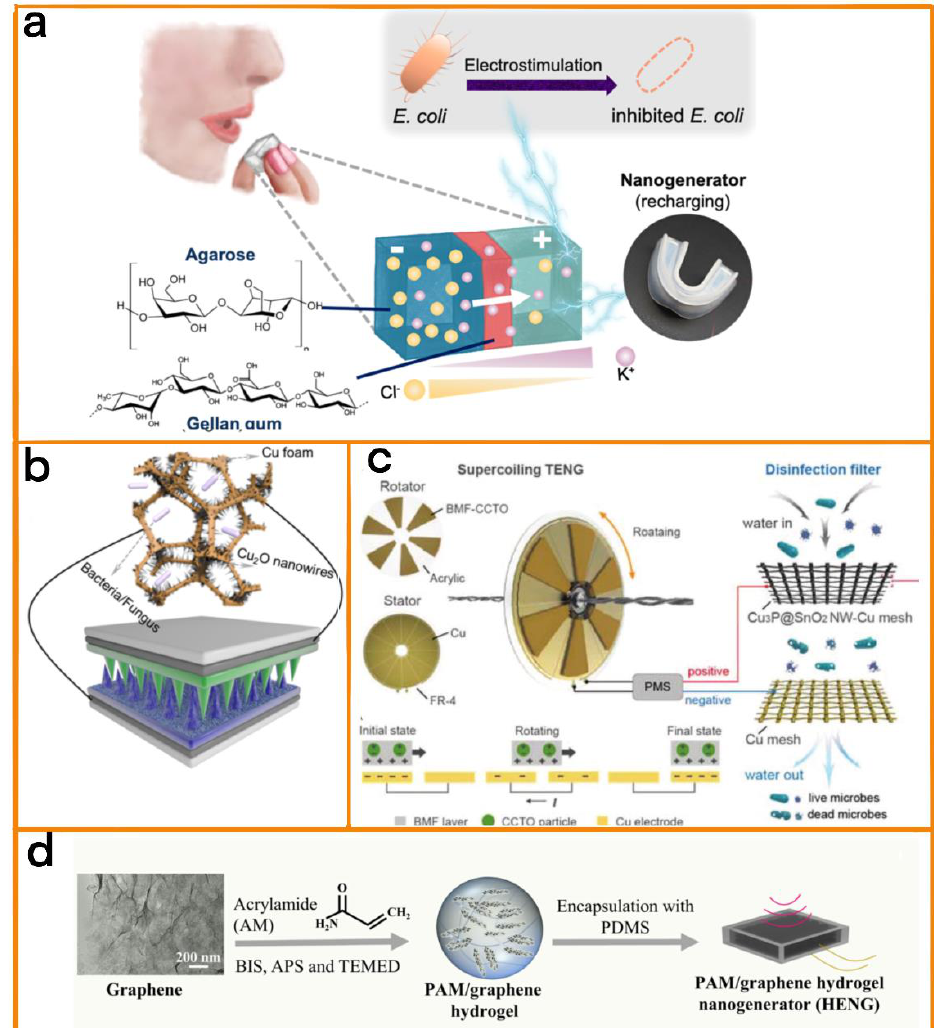
Figure 11. ( a ) Schematic diagram of a cube polysaccharide battery composed of the soft natural hydrogel. Reprinted with permission from [84]. 2021, Elsevier. ( b ) Schematic diagram of